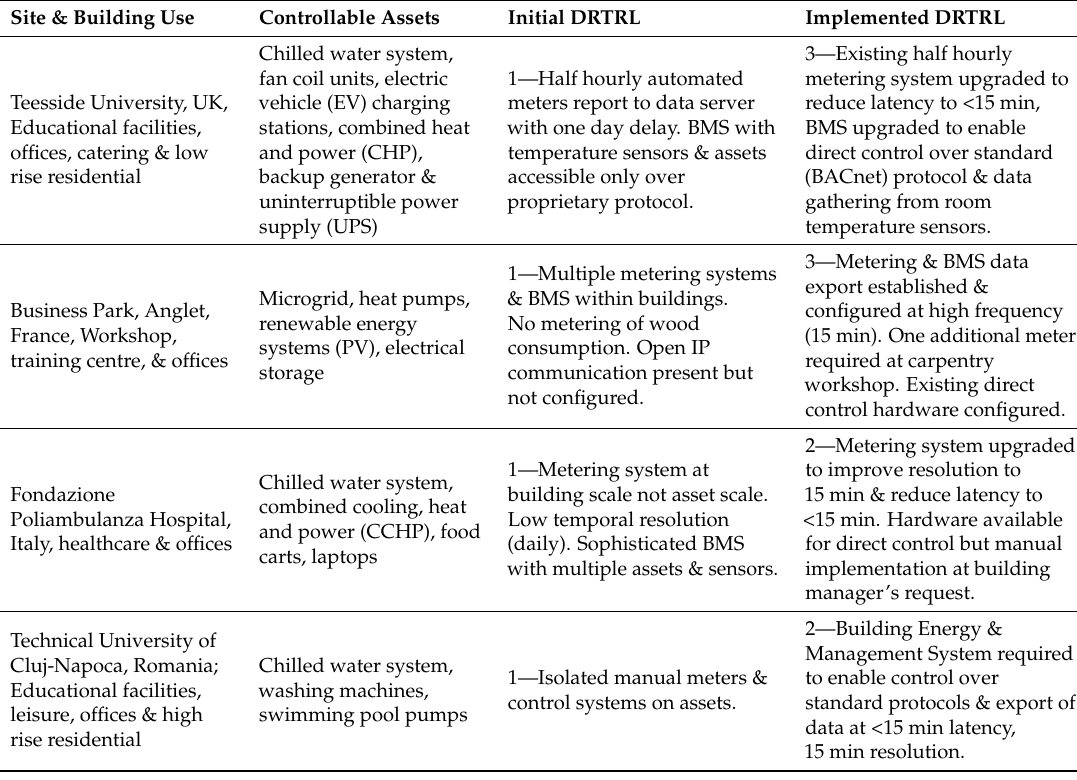
Table 1. DR-BoB pilot sites their uses controllable assets and